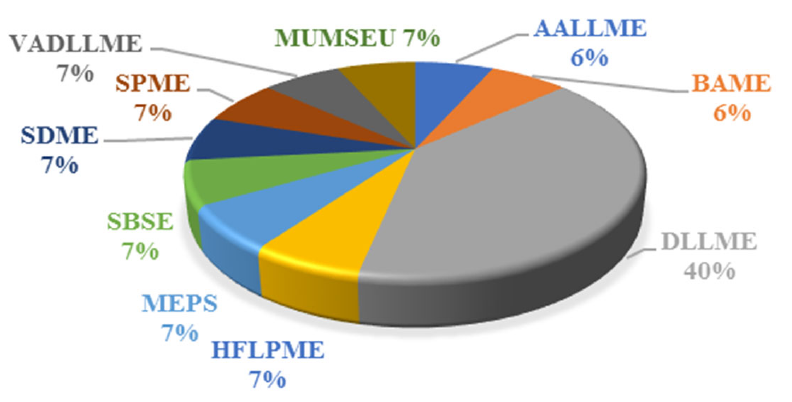
Figure 2. Division of analytical techniques into extraction and microextraction techniques.